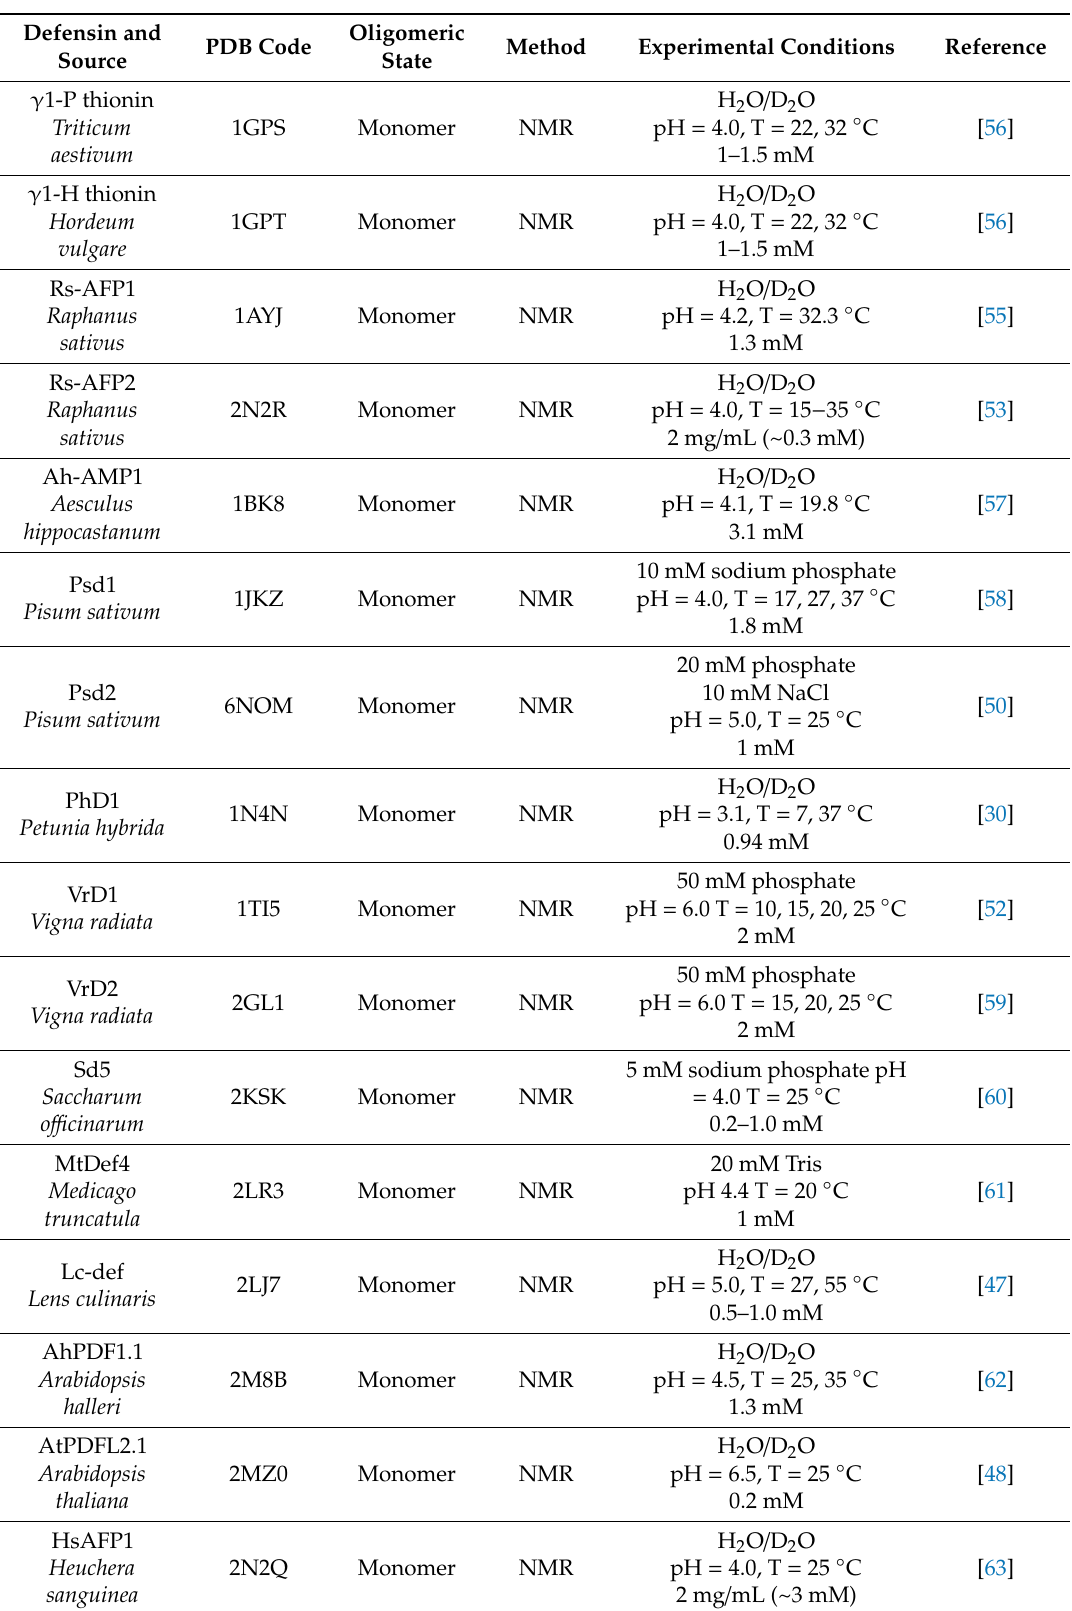
Table 2. Defensins with known three-dimensional structures and their respective PDB codes and experimental